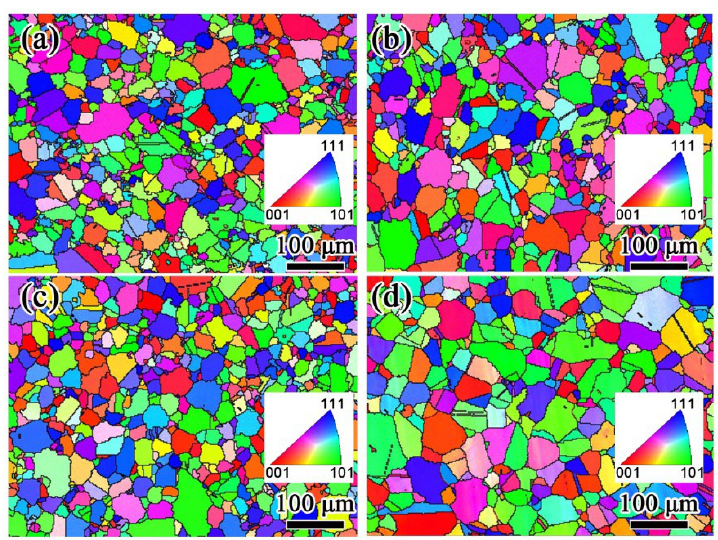
Figure 2. EBSD IPF images of FGH4107: ( a ) as-HIPed; ( b ) HT-1, ( c ) HT-2 and ( d ) HT-3.